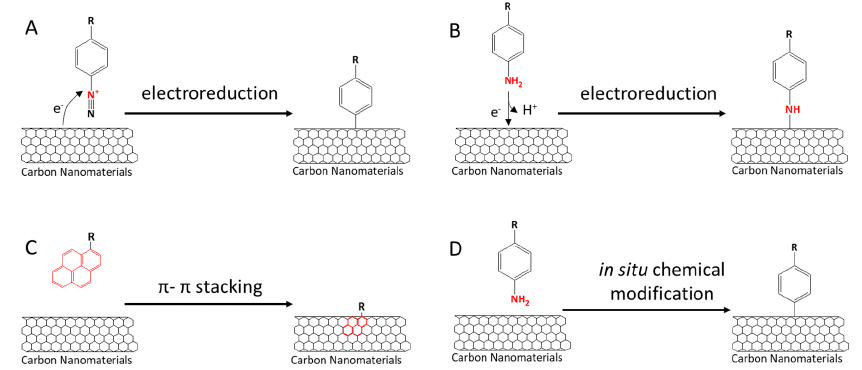
Figure 4. Typical strategies for surface modification of carbon nanomaterials. CNTs were utilized here as representatives of carbon